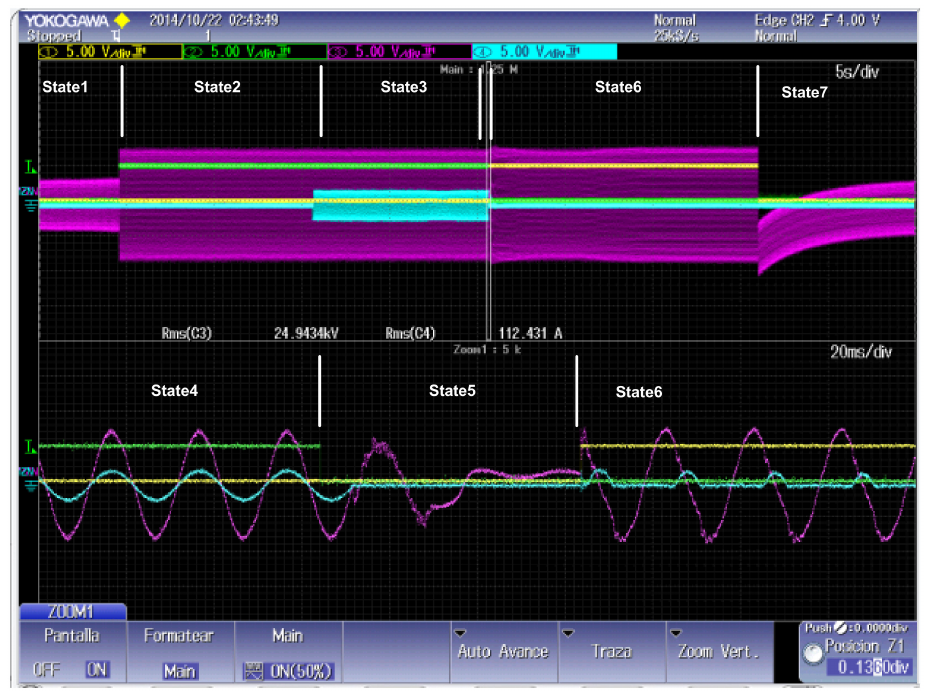
Figure 11. HST travelling at 280 km/h from section 2 to section 1. Ch1, S1 command; Ch2, S2 command; Ch3, NS voltage; Ch4, NS